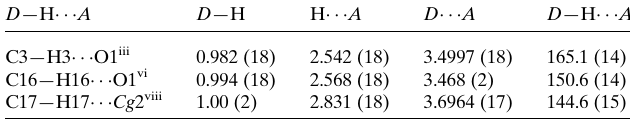
Table 1 Hydrogen-bond geometry (A˚ , (cid:2) ). Cg 2 is the centroid of the C1–C6 benzene ring.